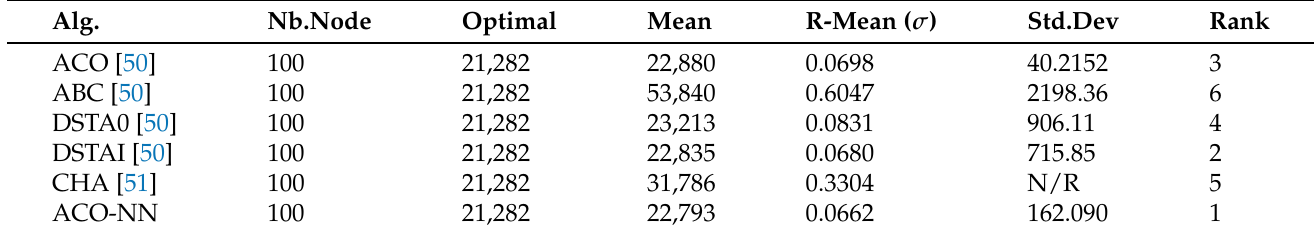
Table 7. Comparison of ACO-NN to various approaches for KroA100.